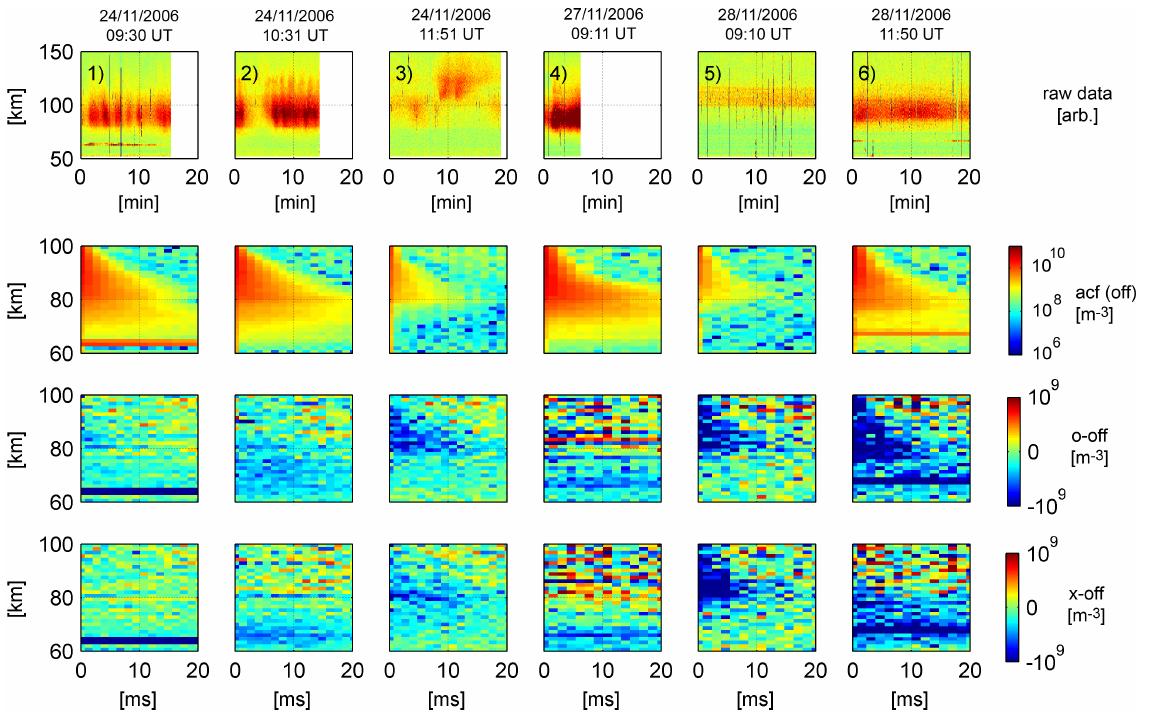
Fig. 1. Measured data in the 6 cases studied. First row of panels: raw un-calibrated IS power (50–150km) as a function of time. Each window is 20min long. Second row: mean ACF (logarithmic scaled absolute value) corresponding to heater off-periods. Zero-lag power is calibrated to the electron density at 120km by using Tromsø Dynasonde. Third row: mean ACF difference between heater o-mode and heat-off periods. Last row: mean ACF difference between x-mode and off